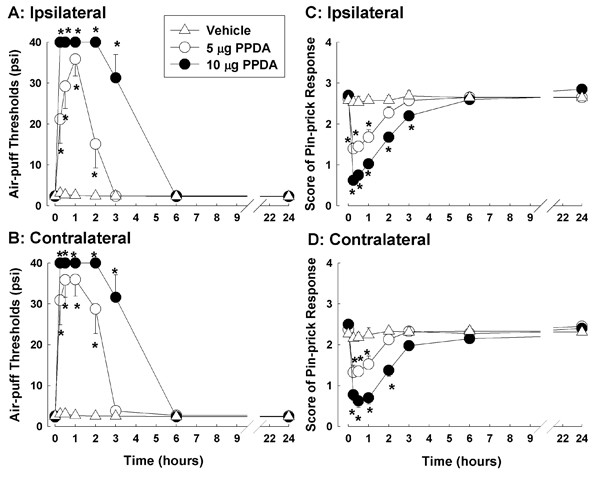
The antinociceptive effects of PPDA in rats with compression of the trigeminal nerve root. The effects of PPDA, a selective NR2C/NR2D antagonist, on mechanical allodynia (A, B) and hyperalgesia (C, D) in rats with compression of the trigeminal nerve root (n = 8 in each treatment group). The intracisternal administration of vehicle did not affect air-puff thresholds in either the ipsilateral (A) or contralateral (B) side. However, injections of 5 or 10 μg of PPDA produced significant anti-allodynic effects in a dose-dependent manner in both sides (A, B). The anti-allodynic effects of PPDA were maintained for two hours after injection of 5 μg of PPDA and three hours after administration of the 10 μg dose. The intracisternal administration of 5 or 10 μg of PPDA also produced significant anti-hyperalgesic effects on the ipsilateral (C) and contralateral (D) side. The anti-hyperalgesic effects of PPPA were completely recovered by six hours after injection with 10 μg of PPPA. Vehicle injections did not affect pin-prick scores in the subject rats. *P < 0.05, vehicle-vs. PPDA-treated groups.